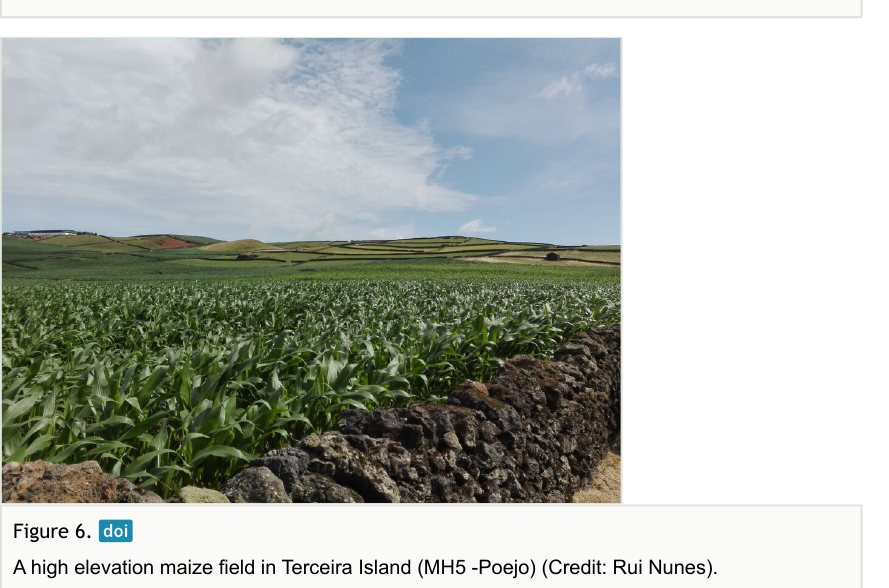
Sampling description: Active Aerial Searching (AAS) and pitfall traps were used to sample arthropod diversity. The following main functional groups were collected: predatory arthropods (mostly spiders, true-bugs, beetles and bugs), phytophagous insects and saprophagous arthropods (mostly millipedes and beetles). AAS consists in picking arthropods found above knee-level by hand, using forceps, pooter or brush and immediately transferring them into vials containing ethanol 96%. It was implemented in five low- and five high-elevation maize fields. Four 1-hour samples were